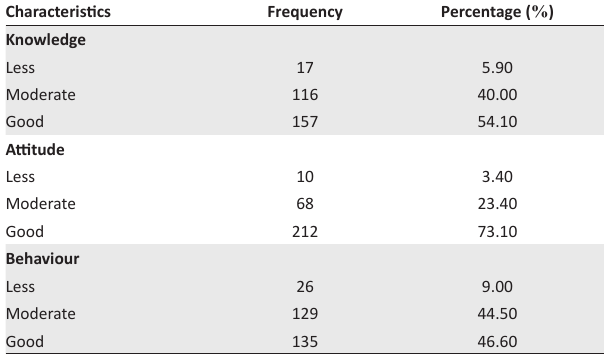
TABLE 3: Demographic characteristics of respondents ( n = 290).